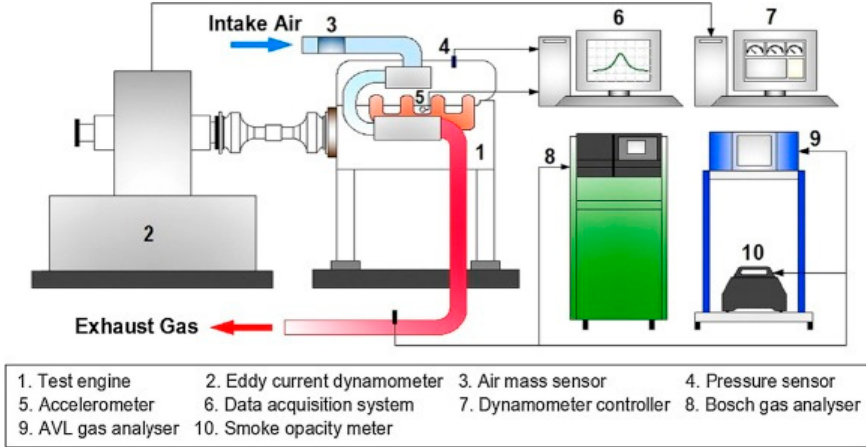
Figure 6. Engine multi ‐ stage injection.